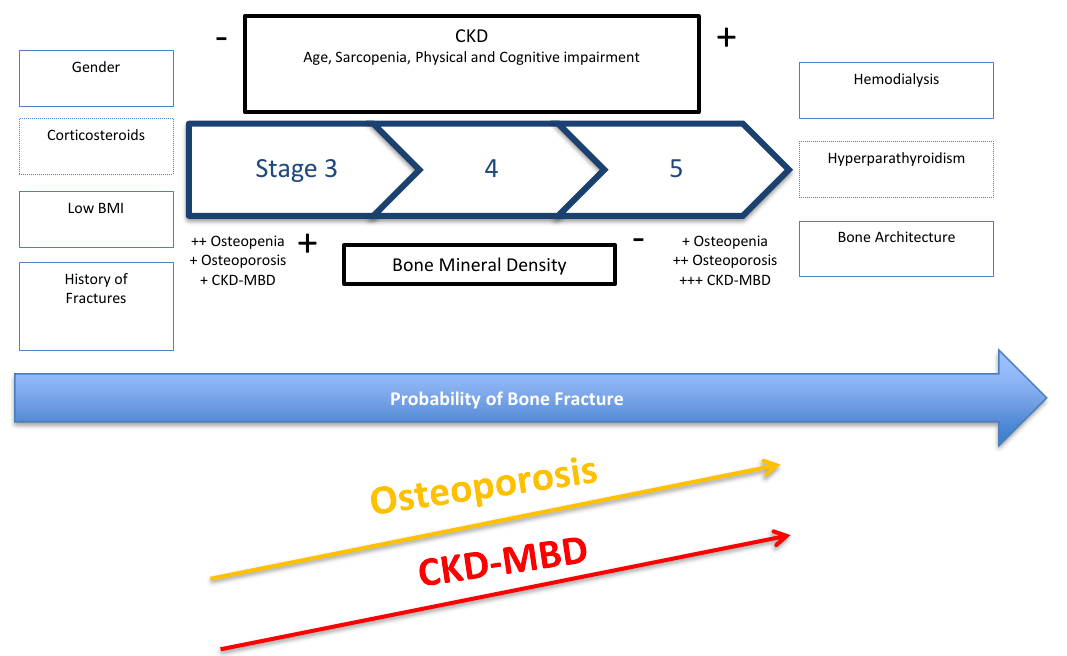
Figure 2. Progression of CKD-MBD from asymptomatic disease to bone fracture, Figure 1. CKD progression: risks factors for bone fragility in CKD stages. In stage 3 it is more likely to have a more relevant contribution of osteoporosis to bone fragility. On the other hand, in stage 5 CKD-MBD and osteoporosis may have a more relevant role. Abbreviation: BMI, body mass index.